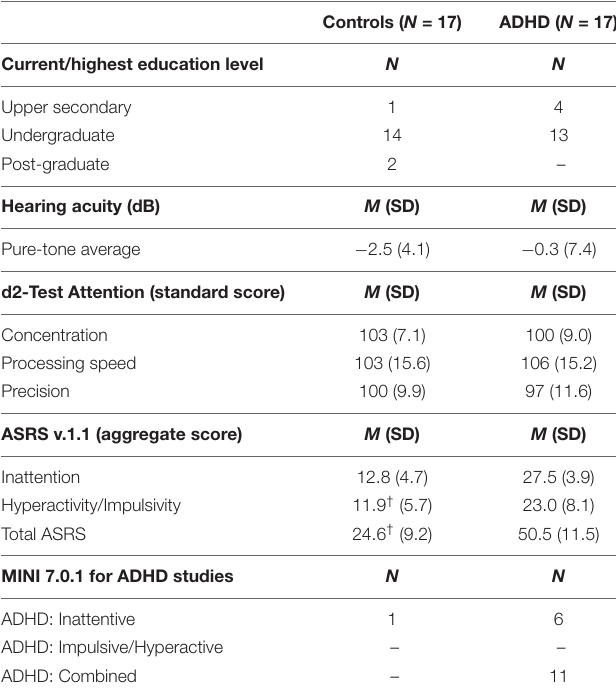
TABLE 1 | Group descriptives for education, hearing acuity and neuropsychological assessments of ADHD-related